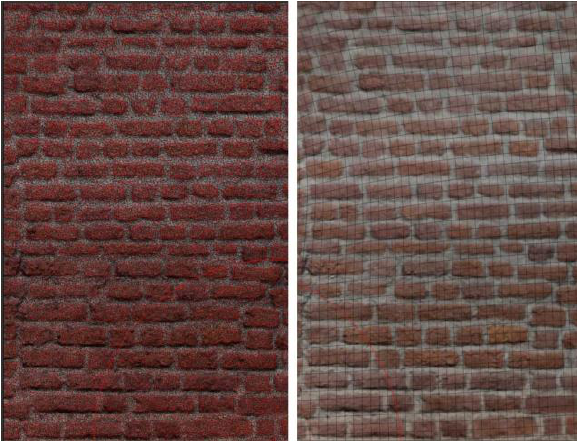
Figure 9. Comparison between the mesh obtained from photogrammetry (left) and the one optimized with ZBrush (right)